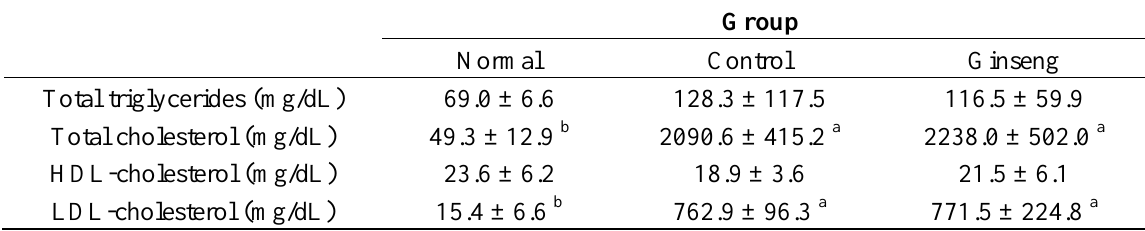
Table 2. Plasma lipid profiles in the rabbits fed the experimental diets. Group Normal Control Ginseng Total triglycerides